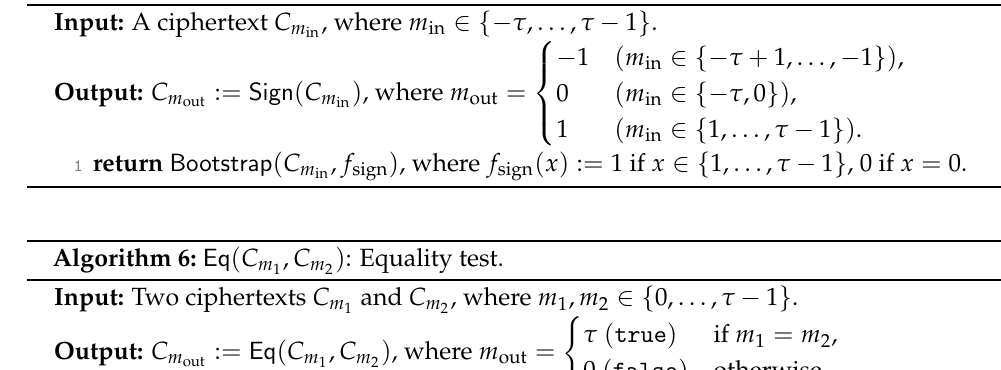
Algorithm 6: Eq ( C m